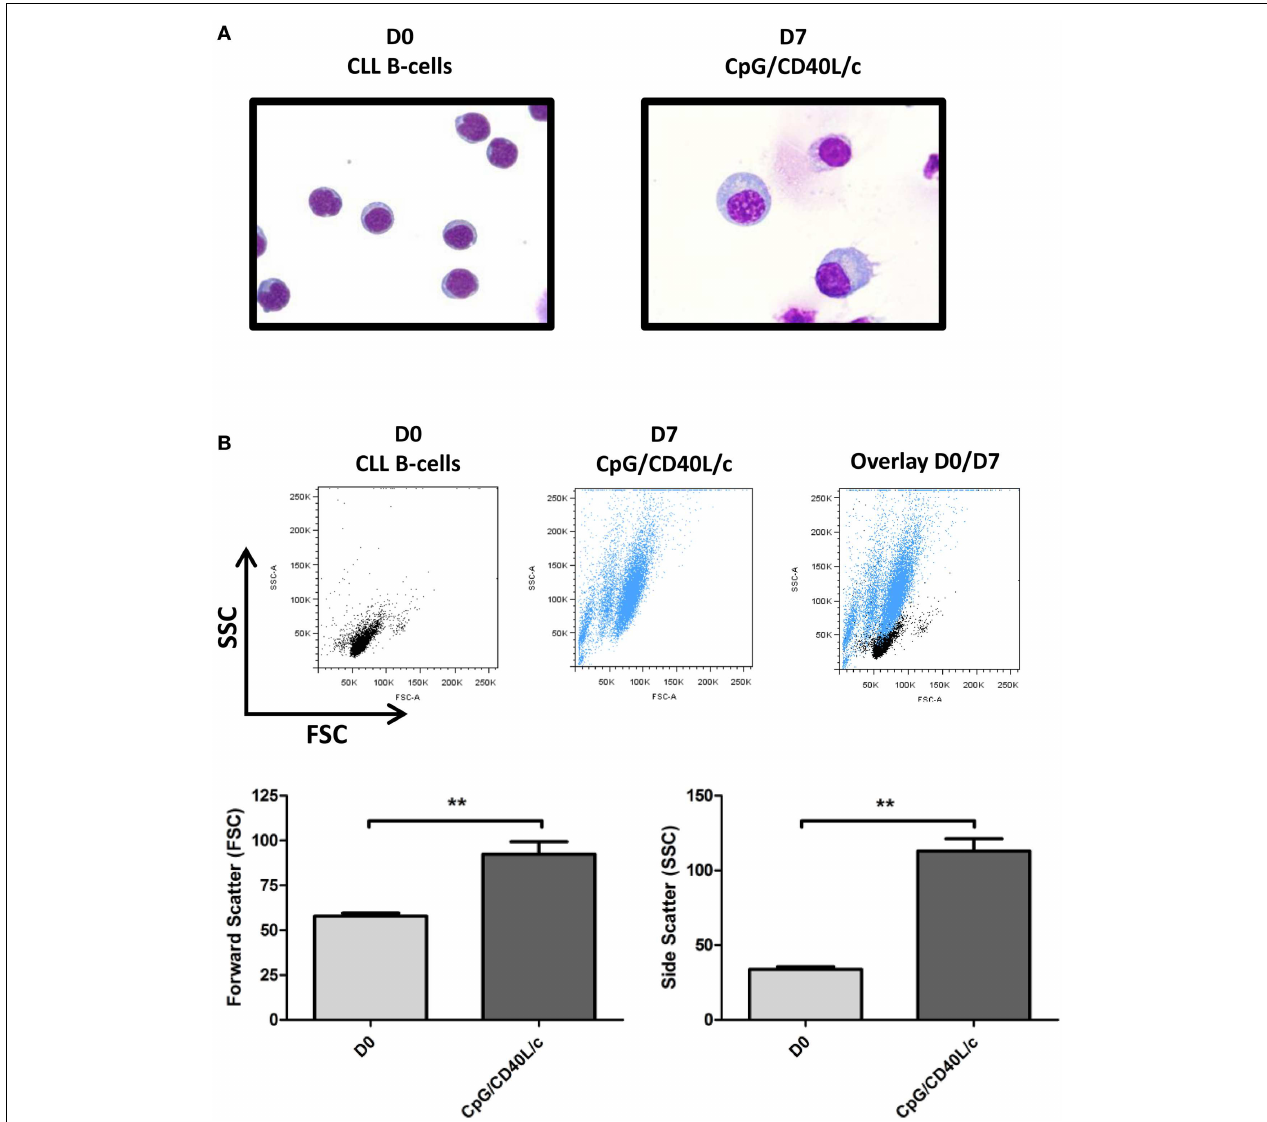
cytometry.The relative cell size is determined by light diffracted at small angles [detected as forward scatter (FSC)].The granularity is proportional to the light diffracted at large angles [detected as side scatter (SSC)].The statistical significance was calculated in aWilcoxon test: ** p <